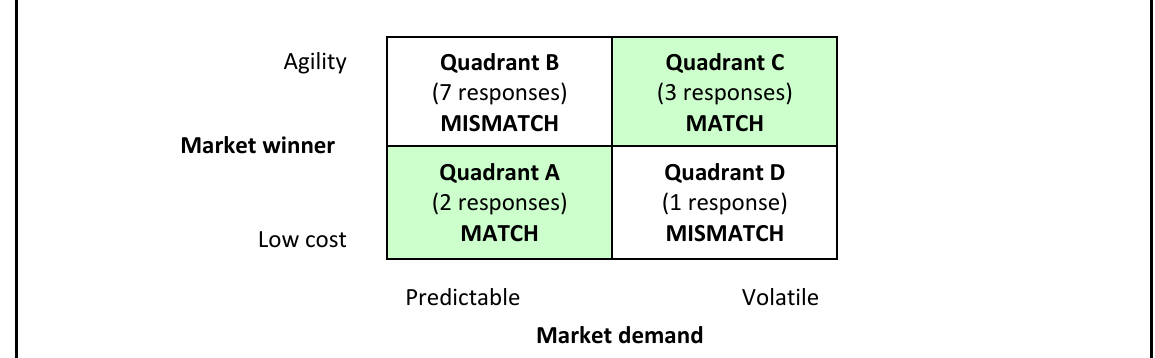
Figure 4: Products according to market demand predictability and market winners